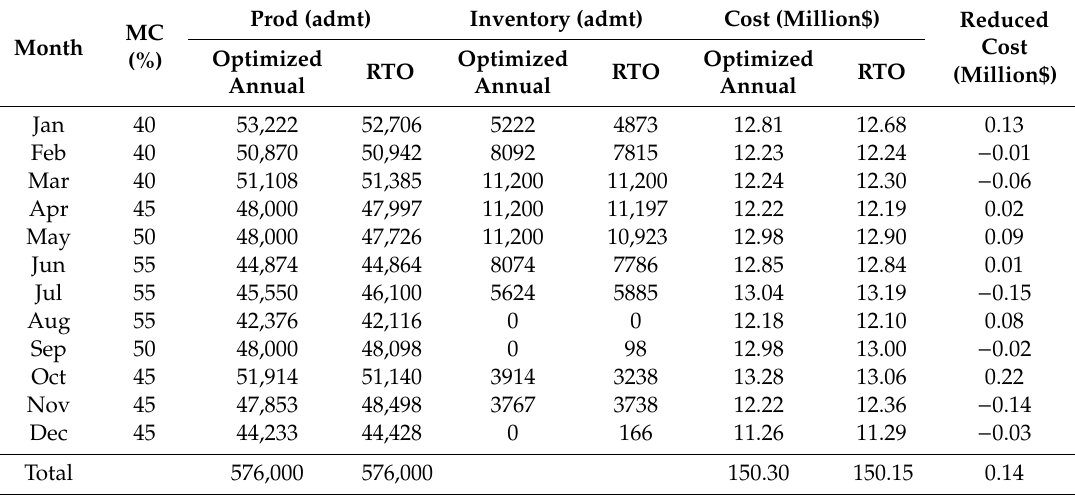
Table 4. RTO results in one